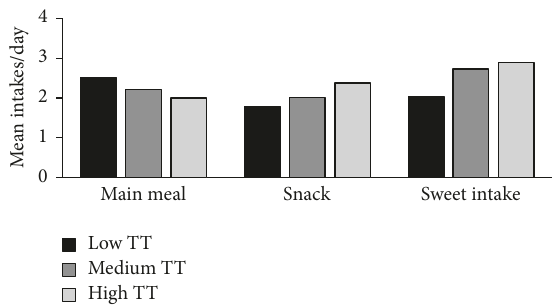
Figure 1: Mean value for main meal, snack, and sweet intake in sweet taste threshold groups. 𝑛 = 225 .